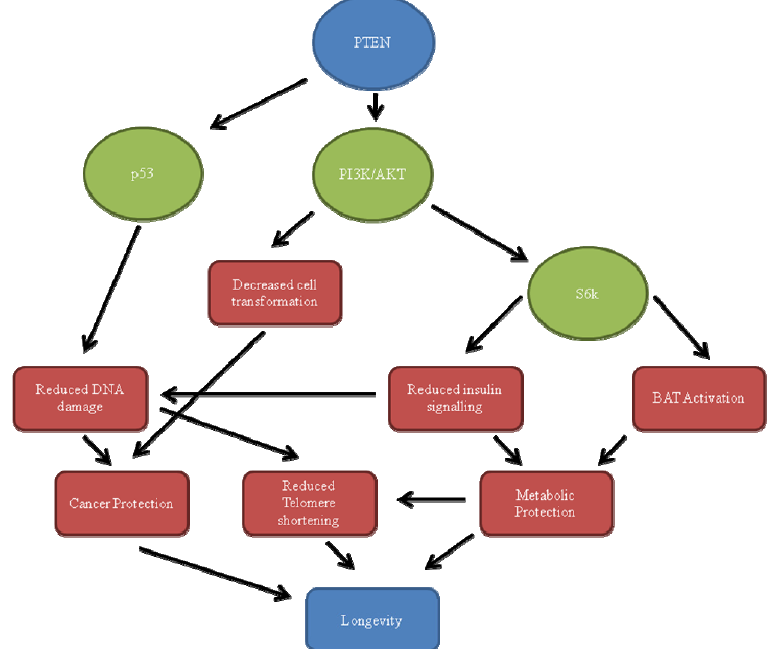
Figure 1. Mechanisms connecting PTEN with longevity. The major functions of PTEN can be seen here: Through down-regulation of the PI3K/AKT pathway (and thus S6K), there is a reduction in cellular transformation, insulin signaling and BAT activation resulting in cancer protection, metabolic protection and reduced telomere shortening. By up-regulating p53, DNA damage is reduced as well as telomere shortening. The result of these is an increased